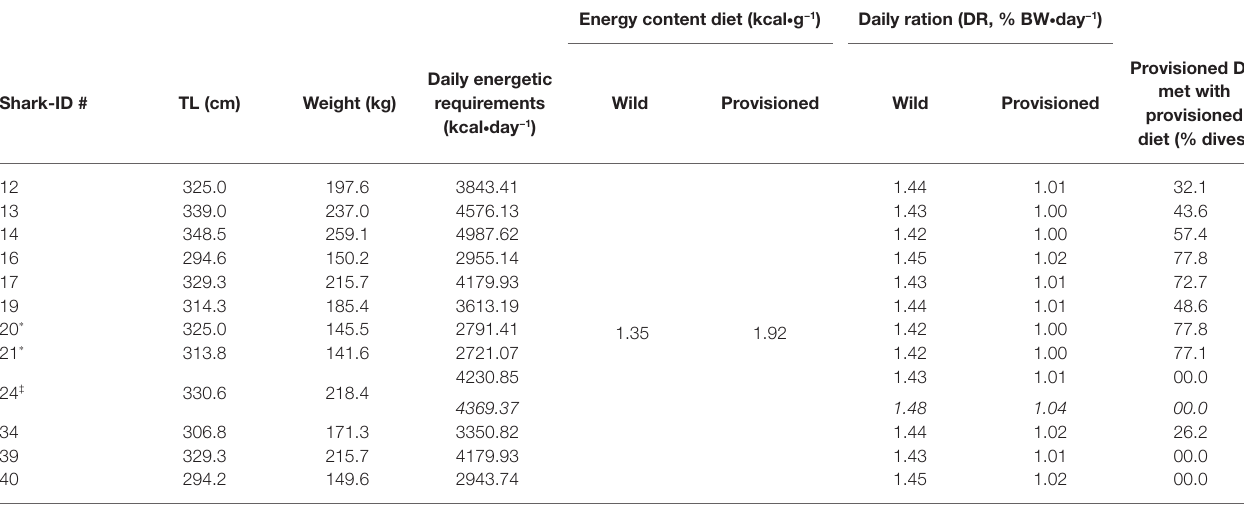
TABLE 6 | Daily ration estimates for great hammerhead sharks ( S. mokarran ) following a wild or provisioned diet.